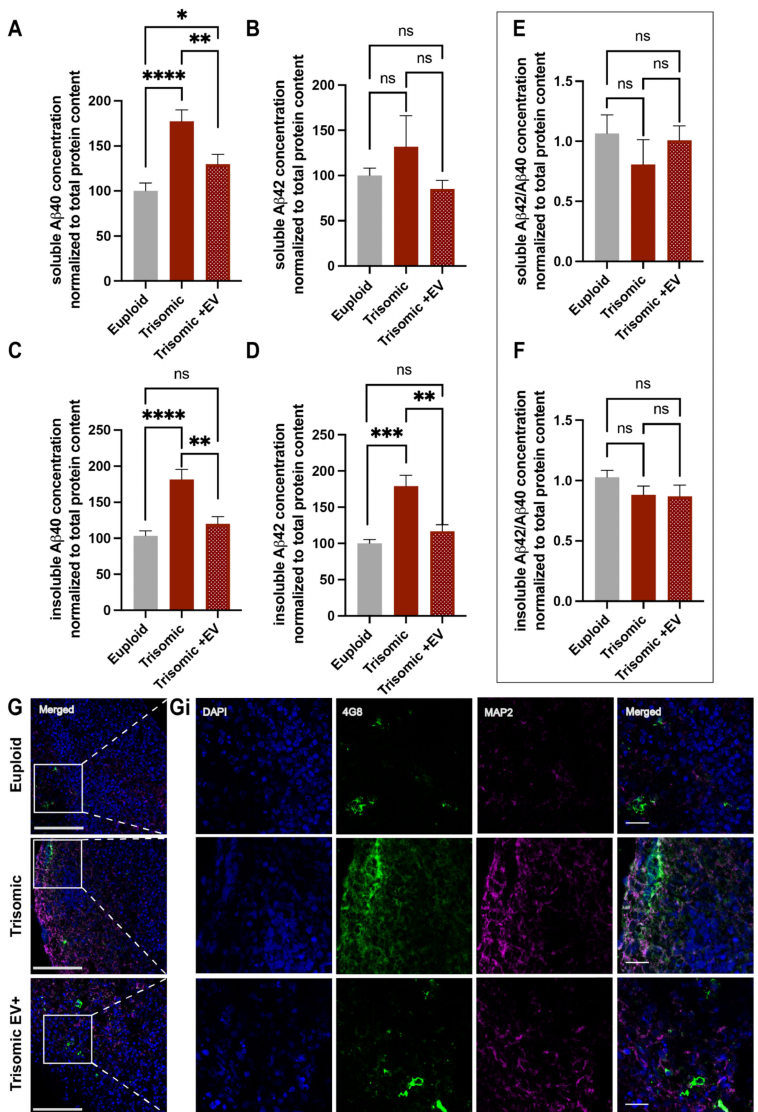
Figure 6. Measurements of A β 40 and A β 42 levels following EV treatment. ( A , B ) Bar graphs of soluble A β 40 ( A ) and A β 42 ( B ) concentrations and; ( C , D ) insoluble A β 40 ( C ) and A β 42 ( D )